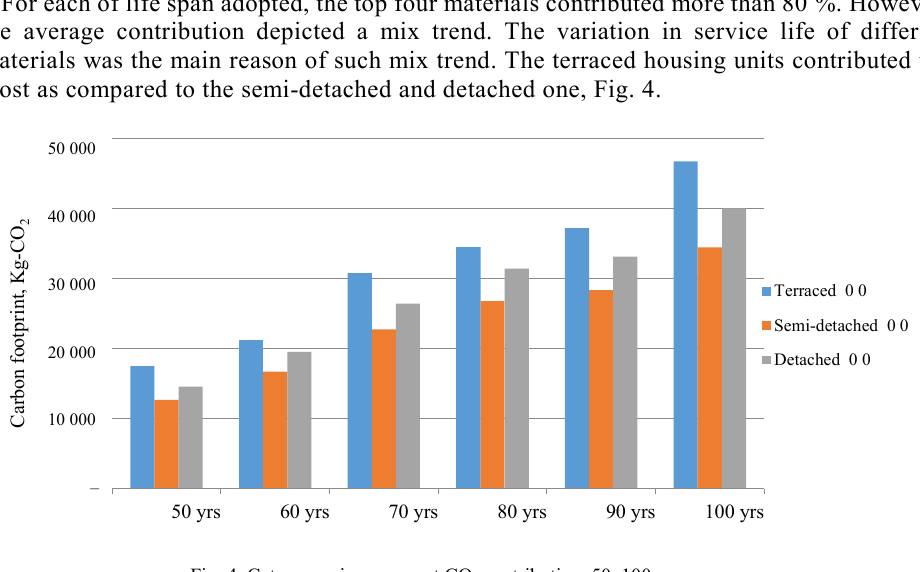
Fig. 4. Category wise recurrent CO 2 contribution, 50–100 years span The 1 st span of 10 years (50 to 60) observed 26 % increase, 2 nd span (60 to 70 yrs.) 41 %, 3 rd span (70 to 80 yrs.) 15 %, 4 th span (80 to 90 yrs.) 7 % and the last span (90 to 100